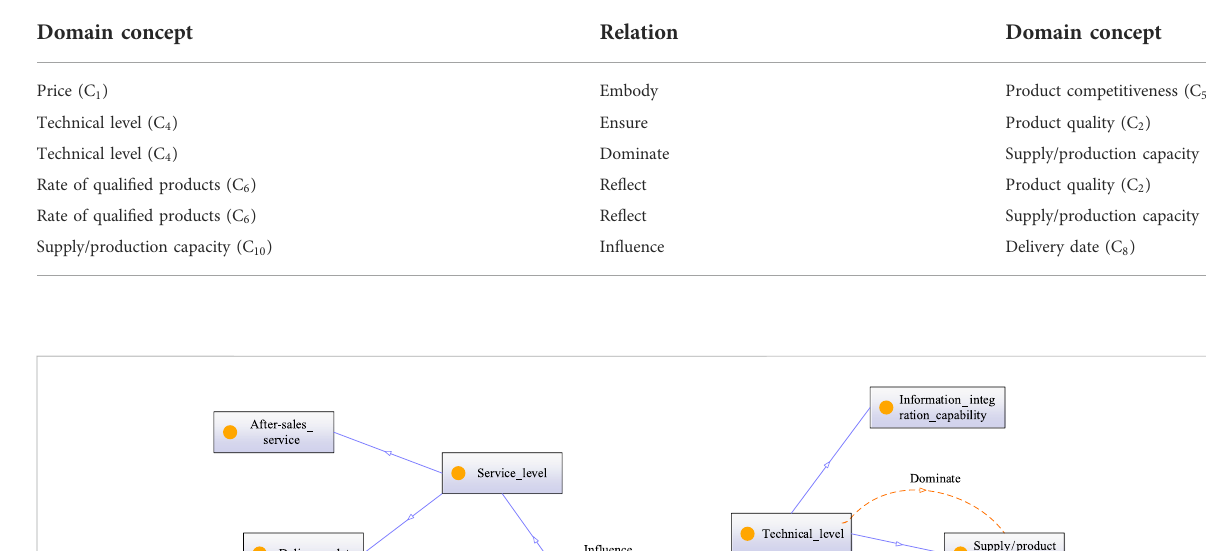
TABLE 5 Non-taxonomic relations of domain concepts.